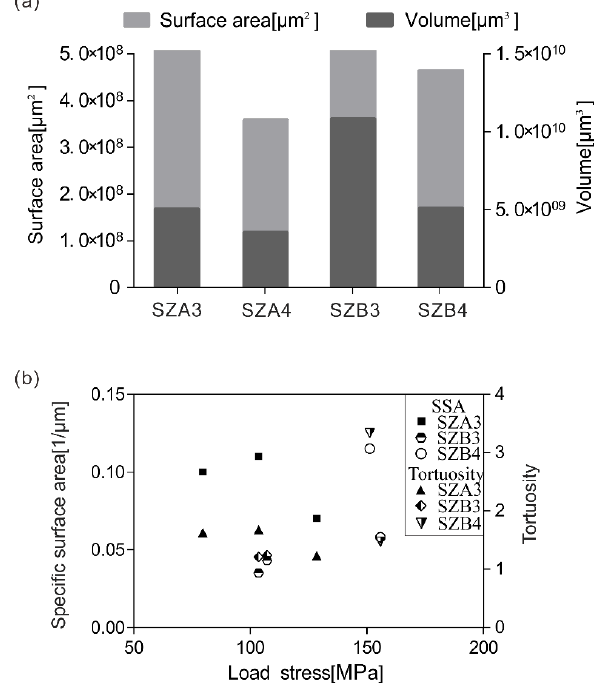
Figure 13. Quantitative characterization of cracks in shale specimens. ( a ) The fracture volume and fracture area at different specimens; ( b ) SSA and tortuosity at different load stages of each specimen.